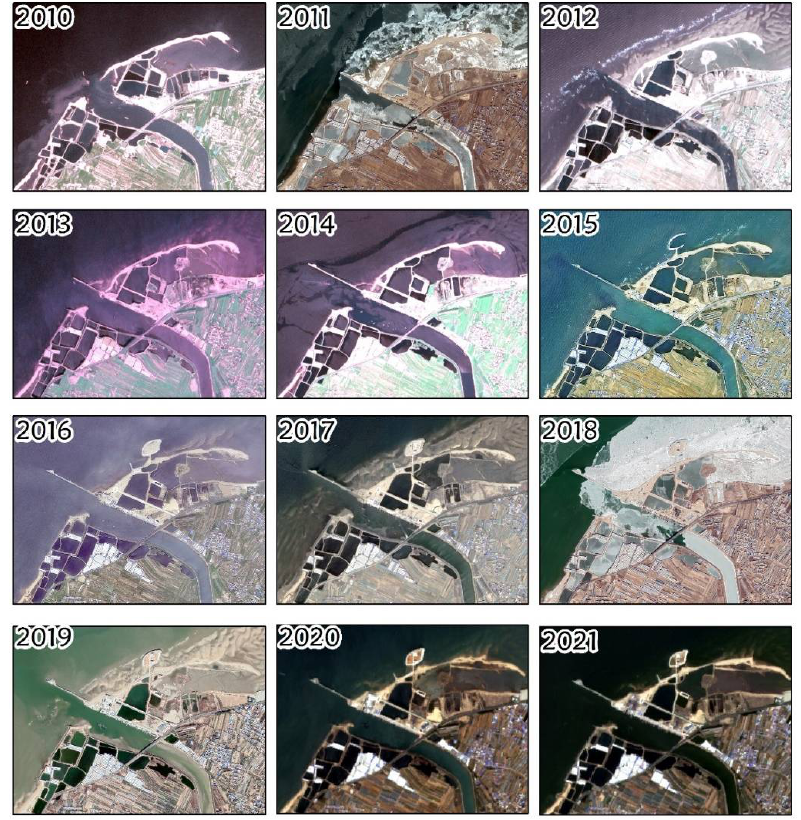
Figure 2. High Resolution Remote Sensing Images of the FESL from 2010 to 2021.